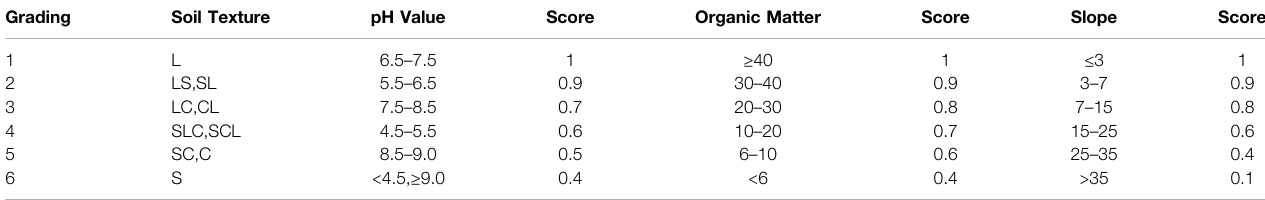
TABLE 3 | Scoring of soil and slope conditions.